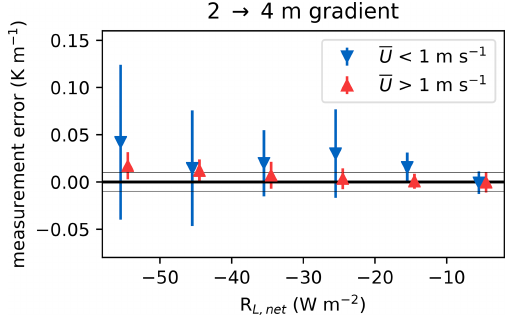
Figure B3. Error in the DTS-measured gradient between 2 and 4m. Data are binned by the net longwave radiation and split into 1m wind speeds under 1ms − 1 (blue, n = 207) and over 1ms − 1 (red, n = 544). Gray lines indicate ± 0.01K. Error bars show ± 1 standard deviation.